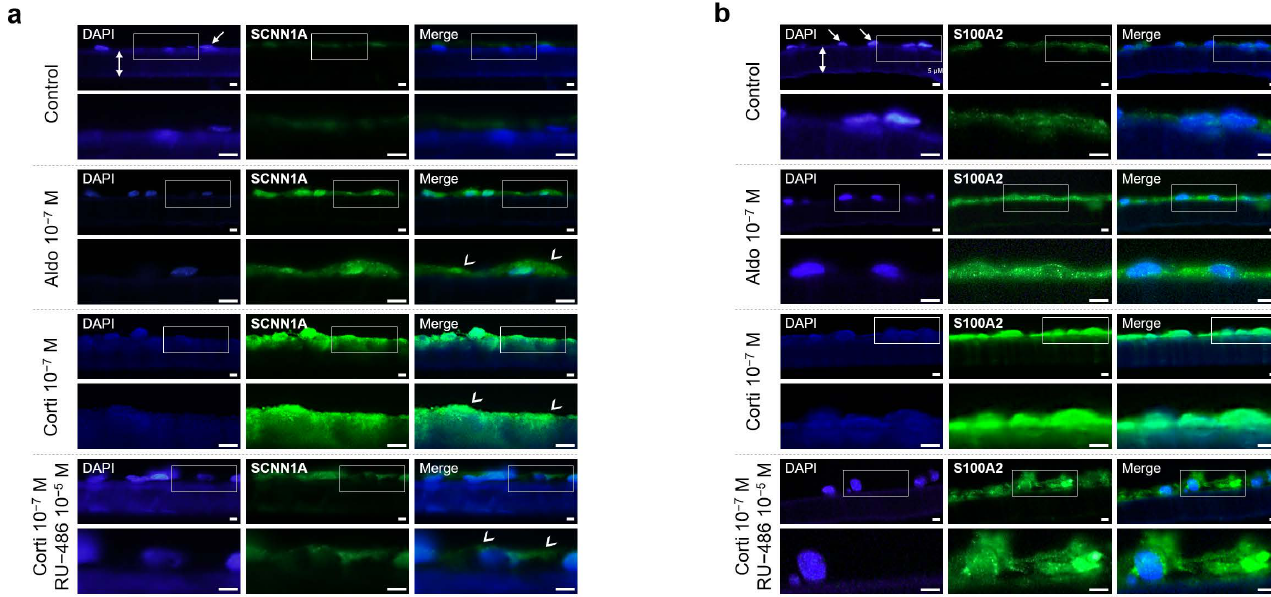
Figure 6. SCNN1A and S100A2 immunohistochemistry in iRPE cells. ( a ) and ( b ) Representative analysis by immunofluores- cence of endogenous SCNN1A ( a ) and S100A2 ( b ) protein expression in iRPE cells cultured on transwell filters (double white arrows) following 24 h treatment of aldosterone (aldo) 10 − 7 M, cortisol (corti) 10 − 7 M or cortisol (10 − 7 M) ± RU-486 (10 − 5 M). SCNN1A and S100A2 staining is in green, and DAPI staining for cell nuclei (white arrows) is in blue, respectively. White arrowheads indicate apical staining ( a ). Scale bar:30 µ m. SCNN1A, sodium channel epithelial 1 α subunit; S100A2, S100 calcium-binding protein